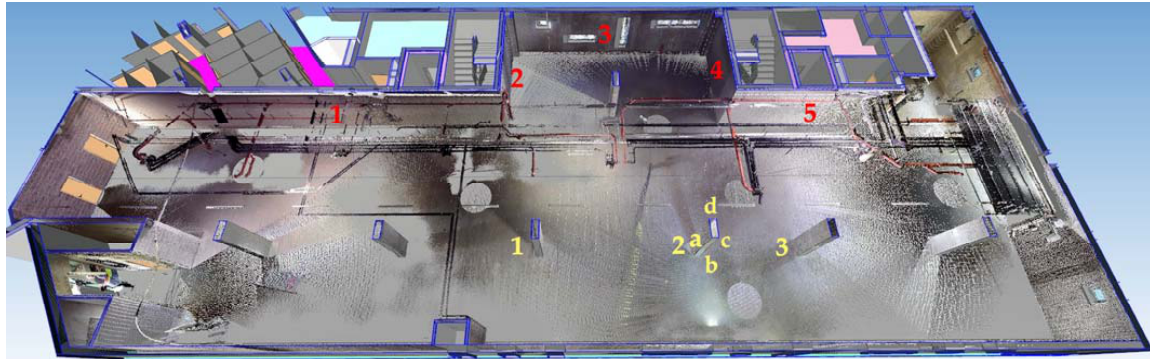
Figure 8. NUPPU—as-planned model (BIM) with the as-built point cloud and the numbering of the chosen elements, the walls with red, and the columns with yellow. The letters indicate the surfaces of the column.